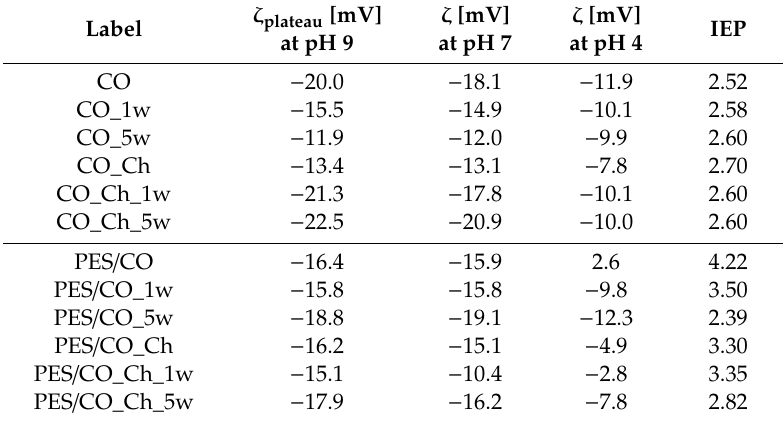
Table 2. The results of zeta potential ( ζ ) at pH 9, pH 7, and pH 4, and Isoelectric point (IEP) of CO and PES / CO